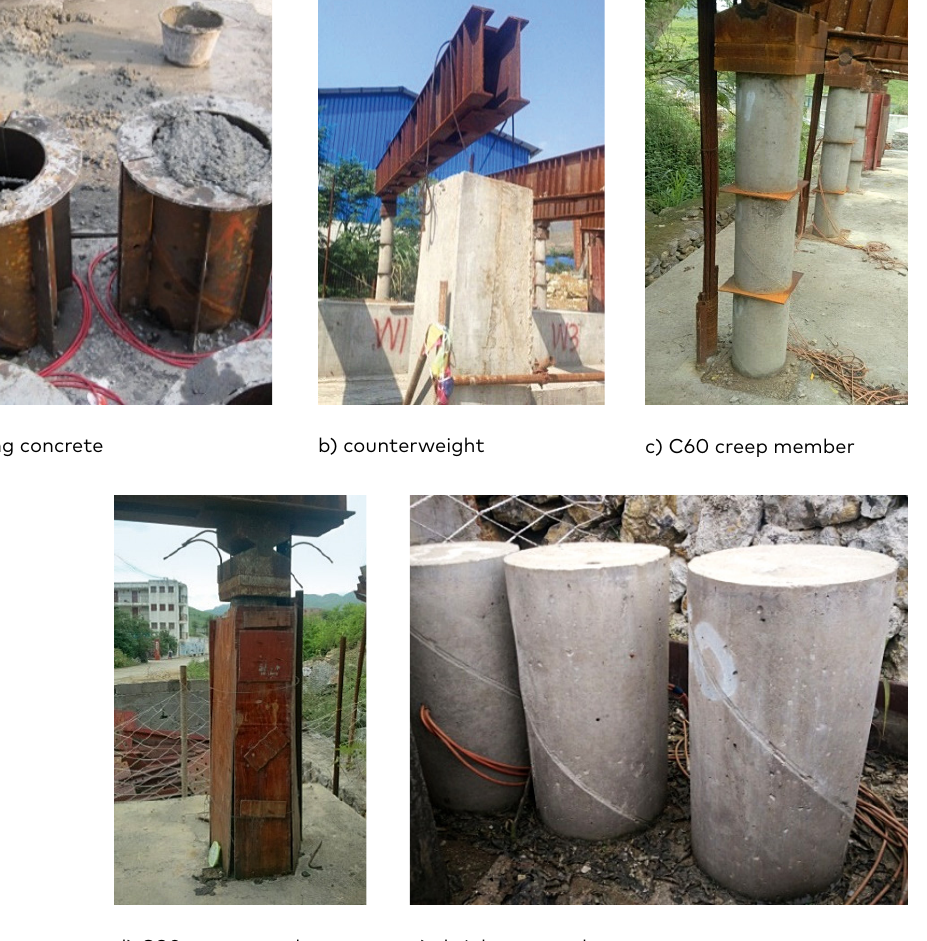
b − the distance between the axis of steel strand and loading F specimen /m; − the distance between the axis of counterweight N G and loading specimen/m; − the force applied on steel strand/N; q − the force applied to the specimens/N; − the dead load of counterweight/N; − represents the transformed uniformly distributed load of steel beam/N